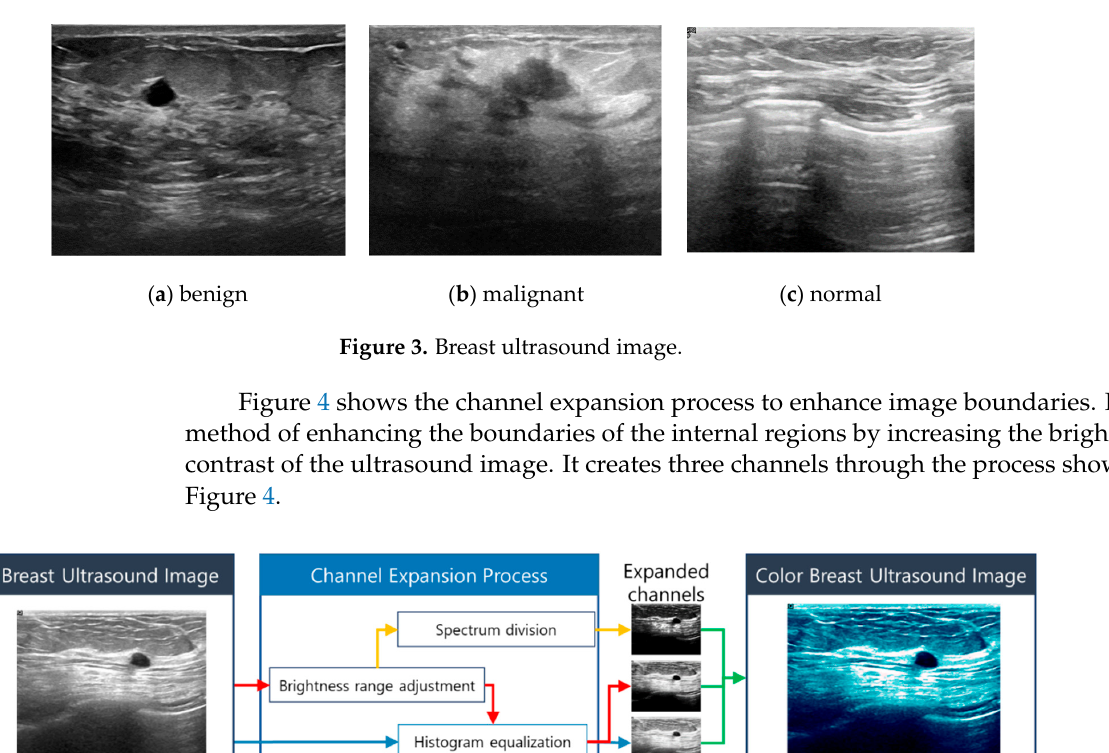
Figure 4. Channel expansion process to enhance image boundaries.